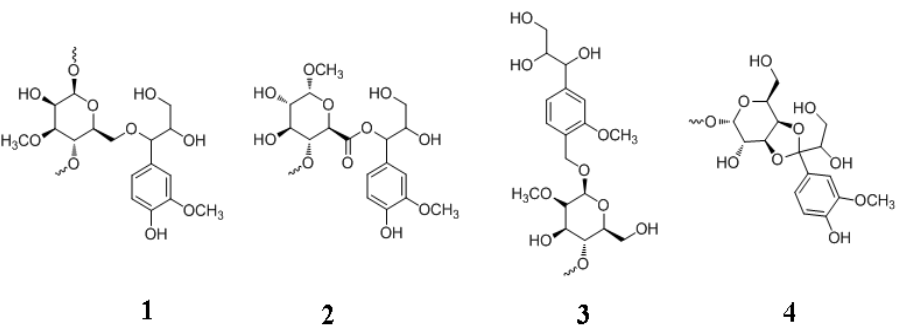
Figure 7. LCC Bonds. 1 , benzyl ether; 2 , benzyl ester; 3 , phenyl glycoside; 4 ,